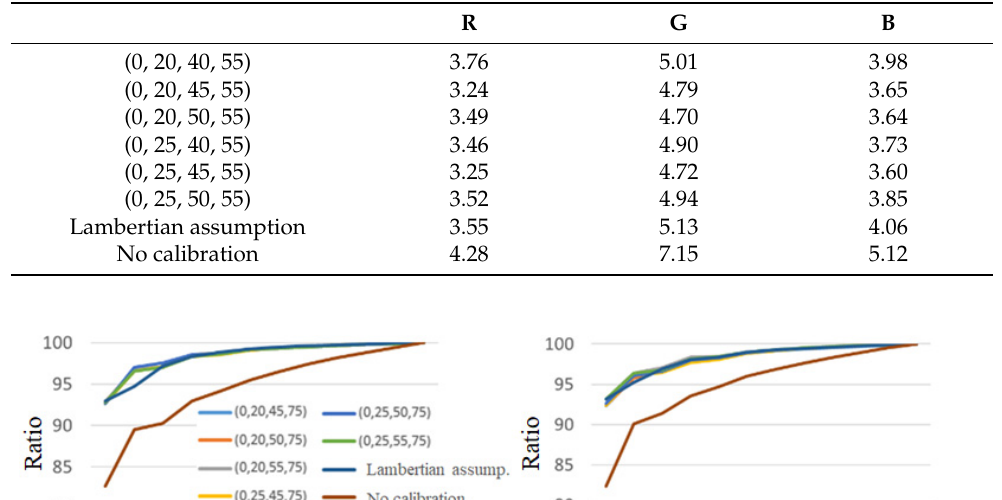
25°, 50°, 75°) or (0°, 25°, 55°, 75°) are relatively better at representing the reflection charac- teristics. Figure 11 shows the results of the projection of the proposed method (0°, 25°, 50°, 75°), the method assuming Lambertian reflection, and the uncalibrated method on an open cylinder. Figure 11 shows that (b) produces thin light and dark stripes, and (c) has a bright center and a darker surrounding area, whereas the result of the proposed method (a) is close to uniform. This indicates that the proposed color calibration method is useful, although its effect varies depending on the color.